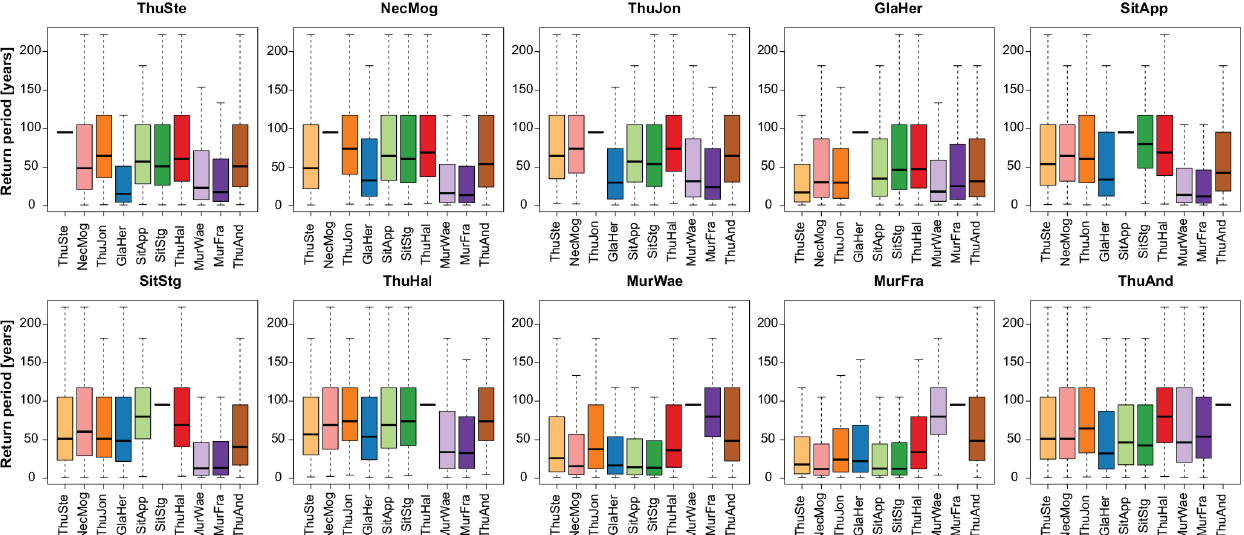
Figure 10. Return period of the events of all stations corresponding to the 100-year flood event determined at one single reference station. The reference station is indicated by the horizontal tick at a return period of 100 years. The interquartile range and the whiskers (last value within 1.5 times the interquartile range) indicate the range of the return periods of the values corresponding to the same event set measured at the other